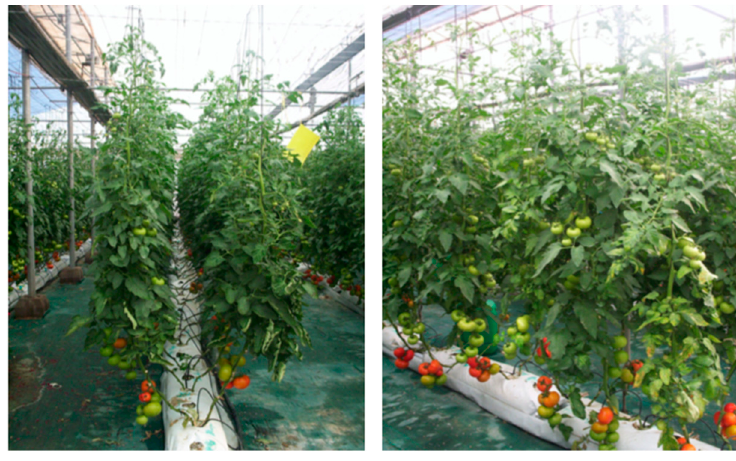
Figure 3. Greenhouse work environment.